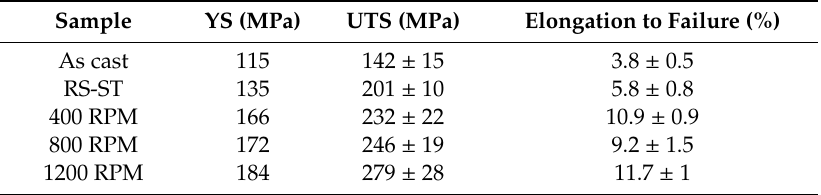
Table 1. Mechanical properties for investigated material